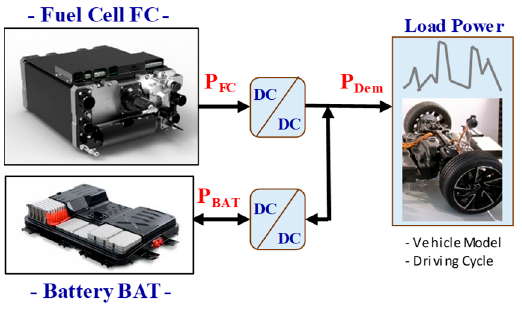
Figure 3. Parallel hybrid power source architecture.